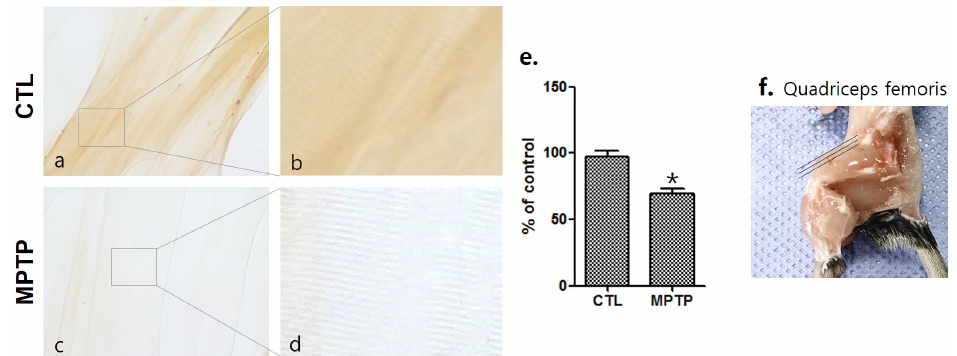
Figure 2. Decrease in serine/arginine-rich protein specific kinase 3 ( srpk3 ) expression in the quadriceps femoris of a chronic MPTP-induced Parkinson’s disease mouse model. Immunohistochemically stained quadriceps femoris using anti-srpk3